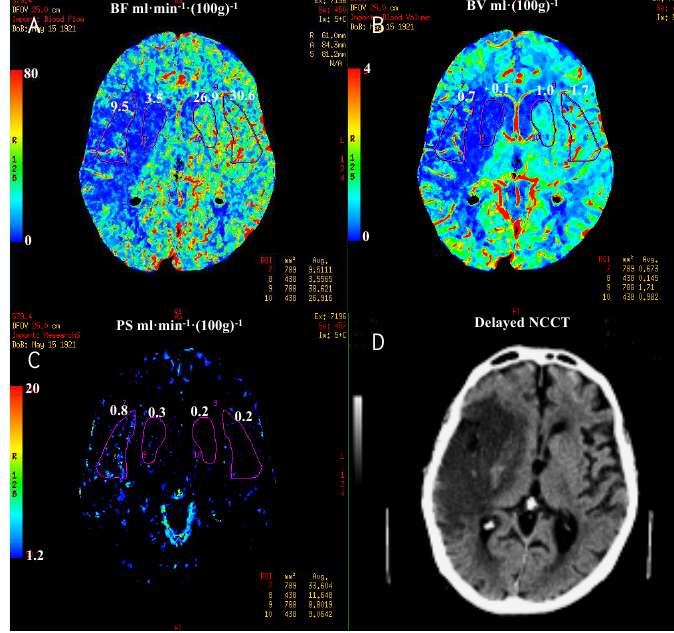
Figure 6. Permeability surface (PS) area product map from a patient with a large area of contrast leakage into the ischemic region: ( A ) CBF map of a 5 mm thick brain slice from the admission CTP study displayed with a color scale from 0 (dark blue) to 150 (red) mL  min −1  (100 g) −1 ( B ) of pixels with CBF less than 25 mL  min −1  (100 g) −1 ; ( C ) corresponding PS map to CBF map in (a) showing the superimposed ischemic ROI and the mirrored ROI in the contralateral hemisphere. PS values in the ischemic and mirrored ROI were 0.40 and 0.122 mL  min −1  (100 g) −1 respectively; ( D ) corresponding delayed non-contrast CT scan of the same slice showing infarct and hemorrhagic transformation (red arrow). Courtesy of Chris d’Esterre, Richard Aviv and Ting-Yim Lee (University of Western